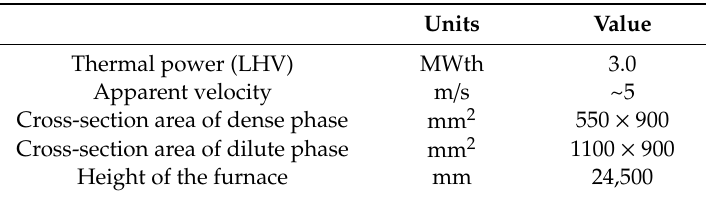
Figure 5. ( Left ) schematic of the CFB rig; ( right ) numerical grid of the furnace. Table 1. Descriptions of the experiments.